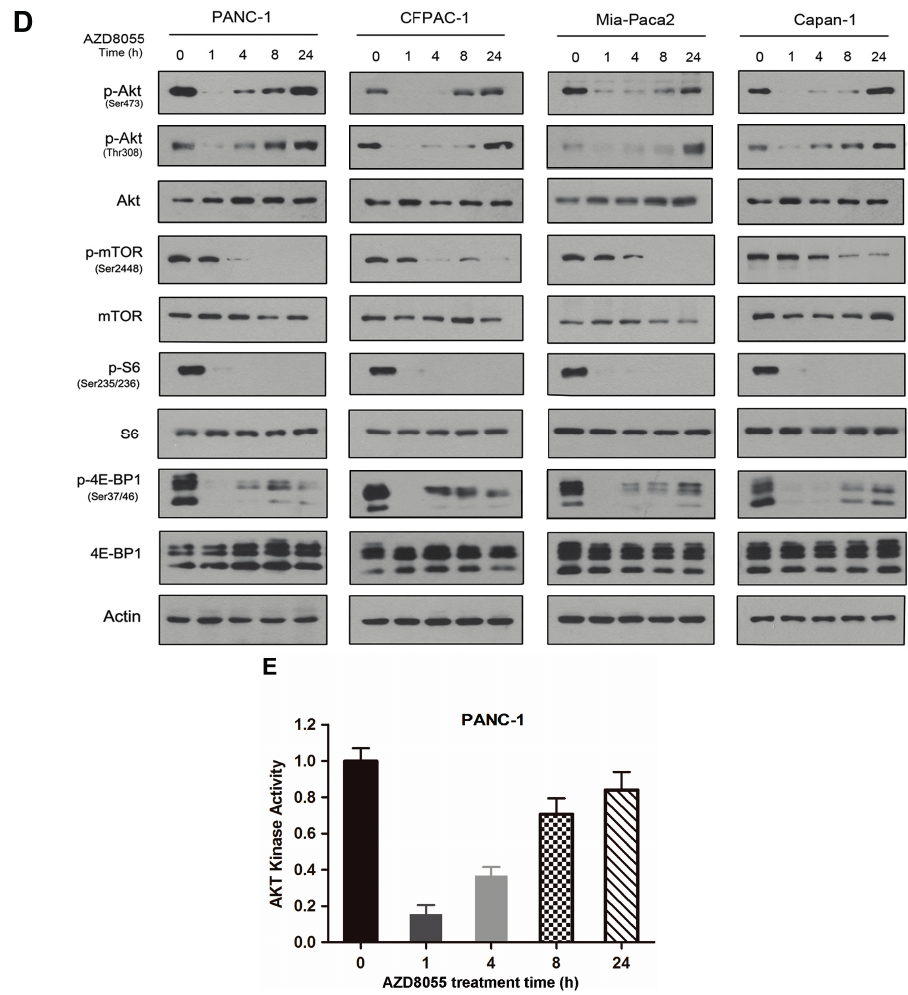
Figure 1. AZD8055 transiently inhibits cell growth of pancreatic cancer. ( A ) The pancreatic cancer cells were treated with AZD8055 or everolimus for 72 h and subjected to cell viability assay. Error bars represent as mean ± SD. NS, not significant; *, p < 0.05; ( B ) cells were treated with AZD8055 in the indicated concentrations and subjected to cell viability assay. Error bars represent as mean ± SD.; ( C ) CFPAC-1 and PANC-1 cells were treated with AZD8055 or everolimus for 24 h and cell cycle were analyzed by flow cytometry. The different colors under the curves were used to describe the cells distributed in the different phases of cell cycle more vividly; ( D ) cells were treated with AZD8055 for the indicated hours and examined by western-blot; ( E ) PANC-1 cells were treated with AZD8055 for the indicated hours and AKT kinase activities were examined by in vitro AKT kinase assay. Data are representative of three